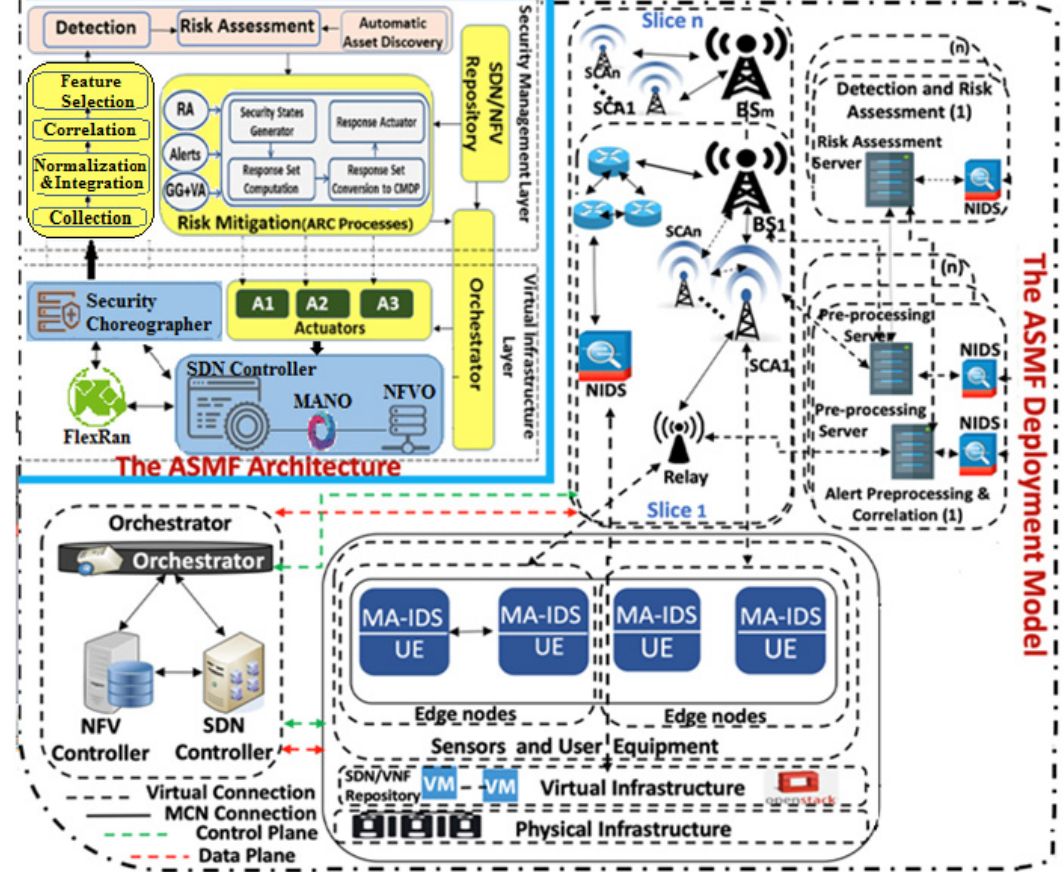
Figure 4. Our 5G Edge security testbed and the ASMF